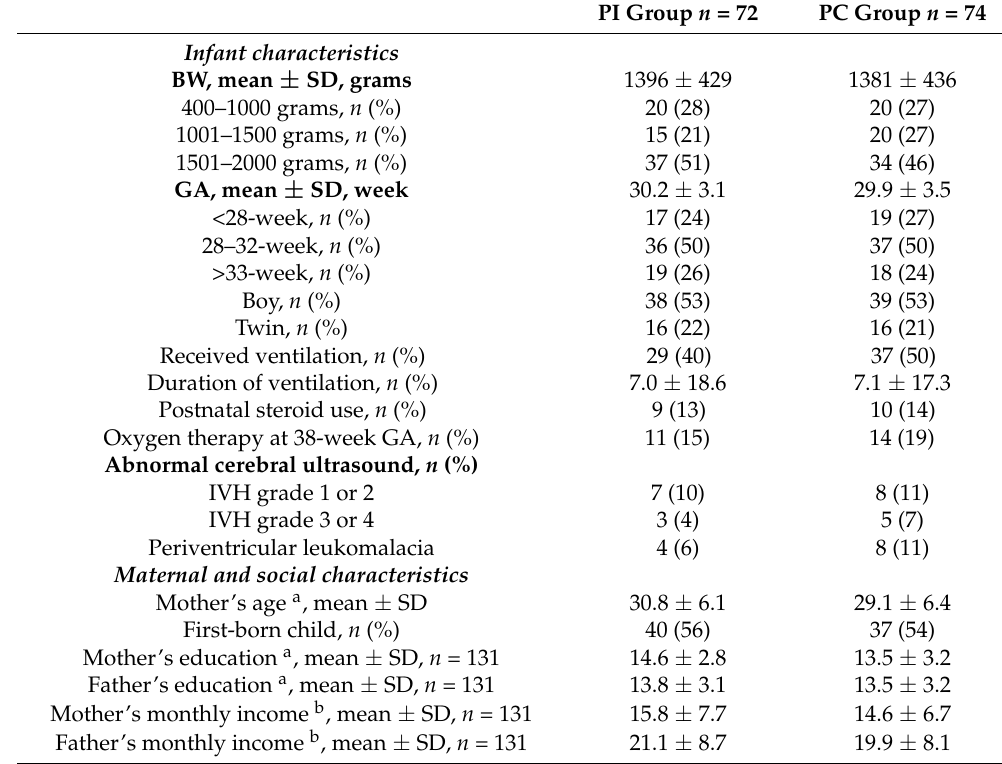
Table 1. Birth, medical, and demographic information on the study sample in